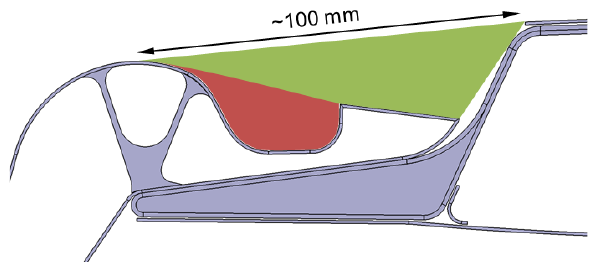
Figure 2. The picture shows a cross section through the rear part of the profile just before the Coanda flap. The green area indicates the available space for installing the active system. The plenum is indicated by the red area.